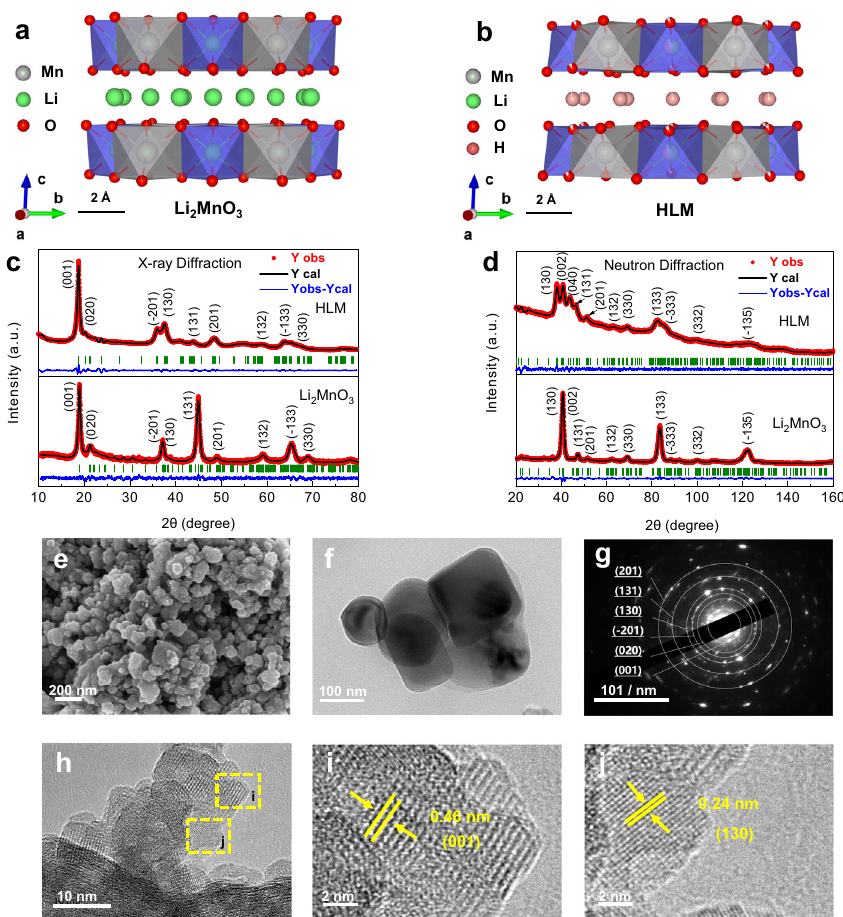
Fig. 1 Structural characterization of Li 2 MnO 3 and HLM. a Crystal structure con fi gurations of Li 2 MnO 3 (O3 stacking) and b HLM (P3 stacking). Rietveld re fi nement pro fi les using c X-ray diffraction and d neutron diffraction data for pristine Li 2 MnO 3 (Crystallography Open Database ID: 1008373) and as- prepared HLM (Crystallography Open Database ID: 4001282) samples. The red circles illustrate the observed pattern, the black solid line is the calculated pattern, the green vertical markers show the calculated Bragg re fl ection positions, and the blue line is the difference between the observed pattern and the calculated pattern. e SEM image of HLM. f TEM images of HLM. g Electron diffraction patterns from [101] of HLM. h HR-TEM images of HLM. i , j HR-TEM images of selected regions of HLM. Table 1 Crystallographic details of Li 2 MnO 3 and HLM samples obtained from joint Rietveld analysis using XRD and ND data. Atom Li 2 MnO 3 (space group: C2/m ), Z = 4 a = 4.918(5) Å, b = 8.487(9) Å, c = 4.945(7) Å, β = 108.8(5)°, V = 195.3(9) Å 3 χ 2 = 1.61, R F = 1.36%, R B = 2.59%,